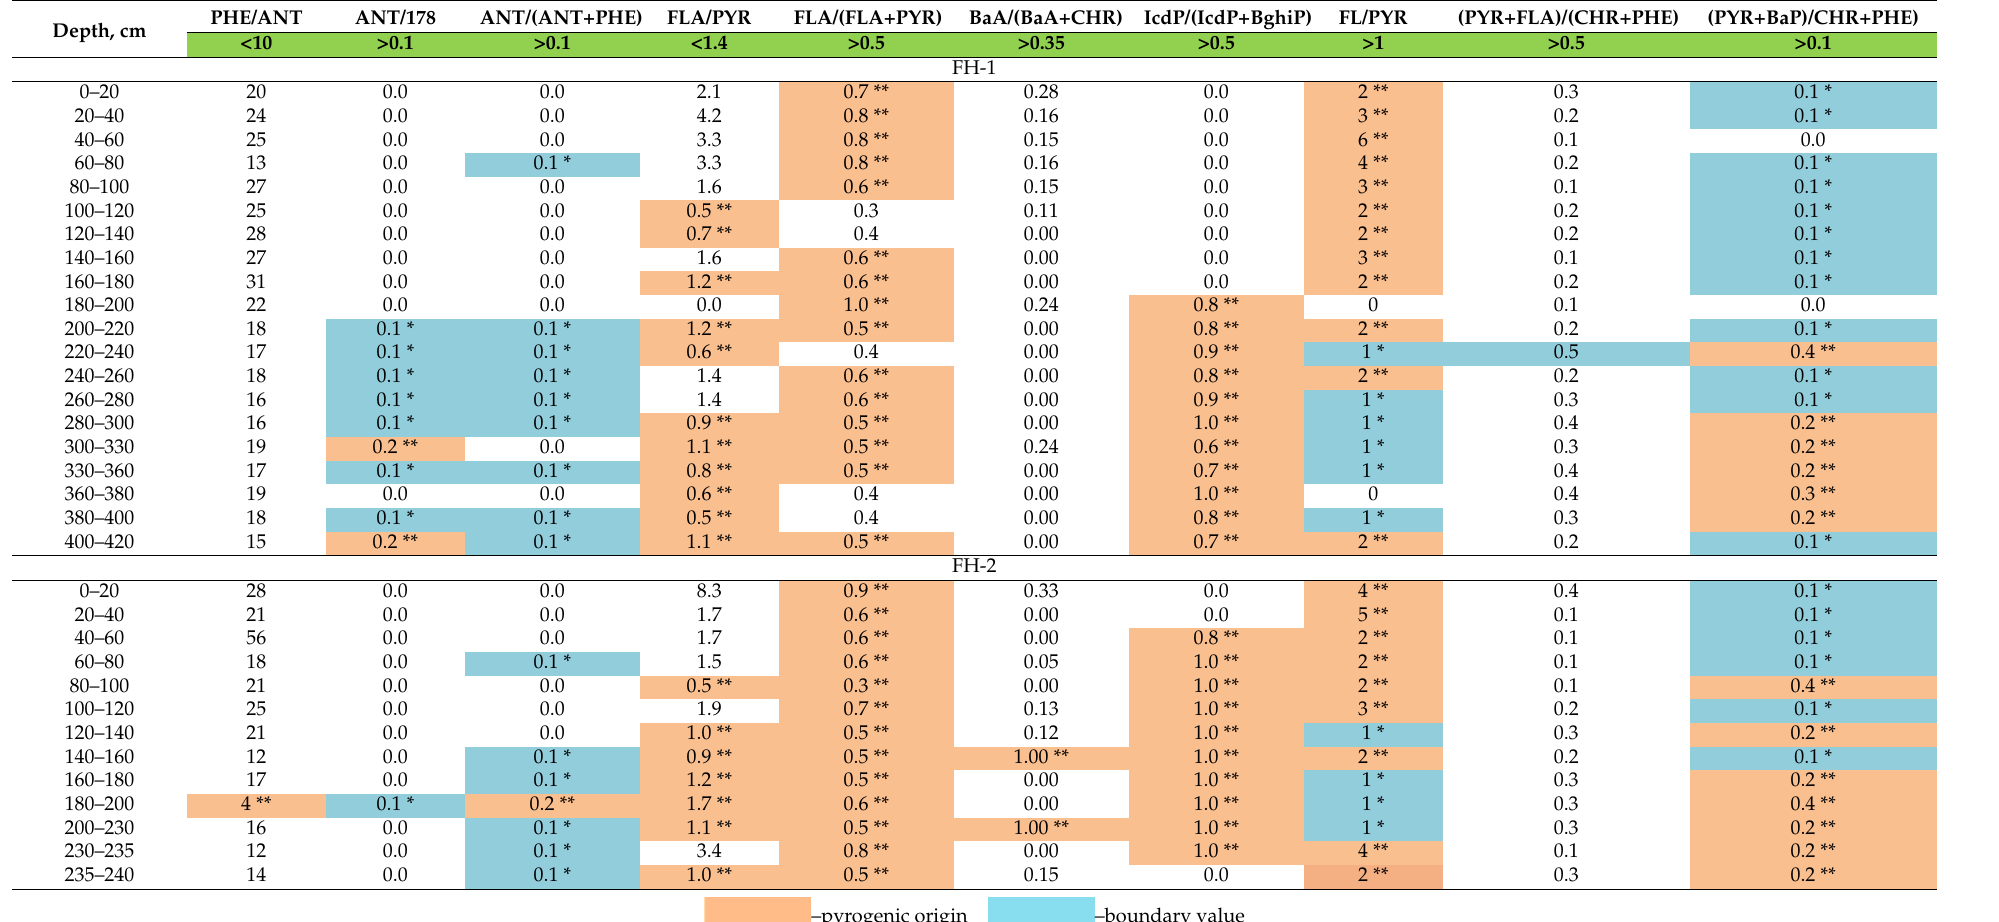
Table A2. The diagnostic ratios of